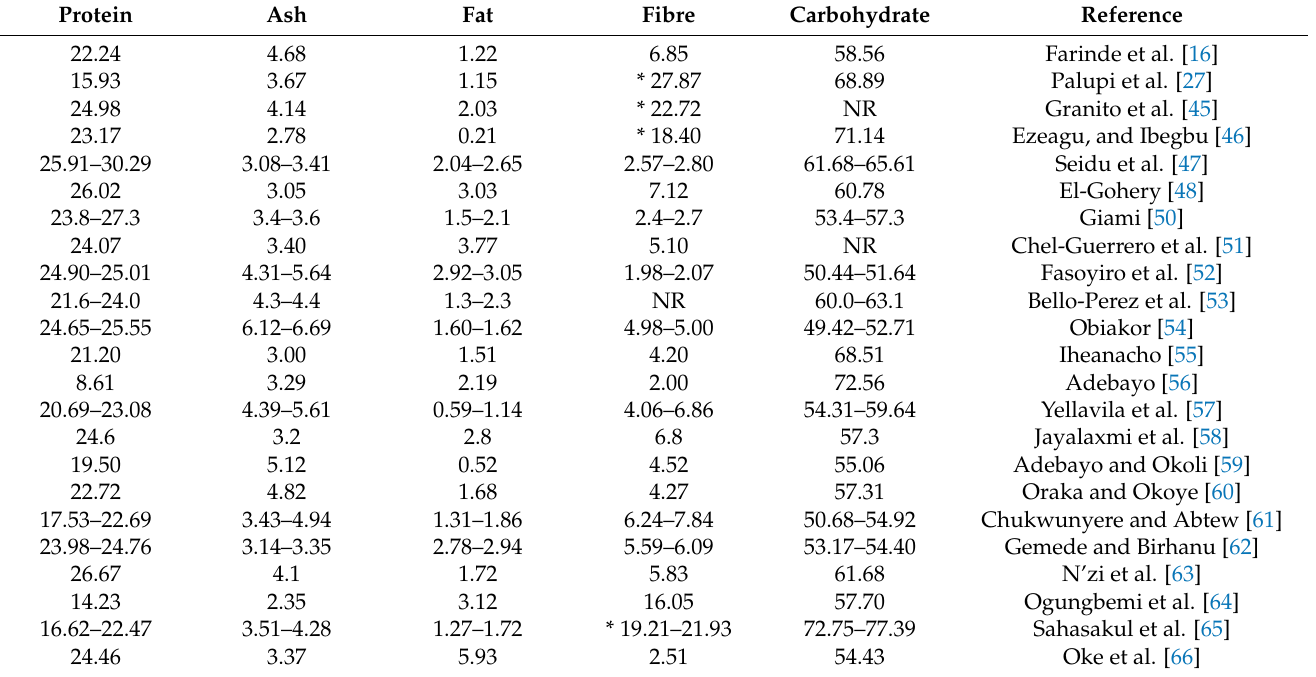
Table 1. Nutritional composition (%) of lima bean reported in